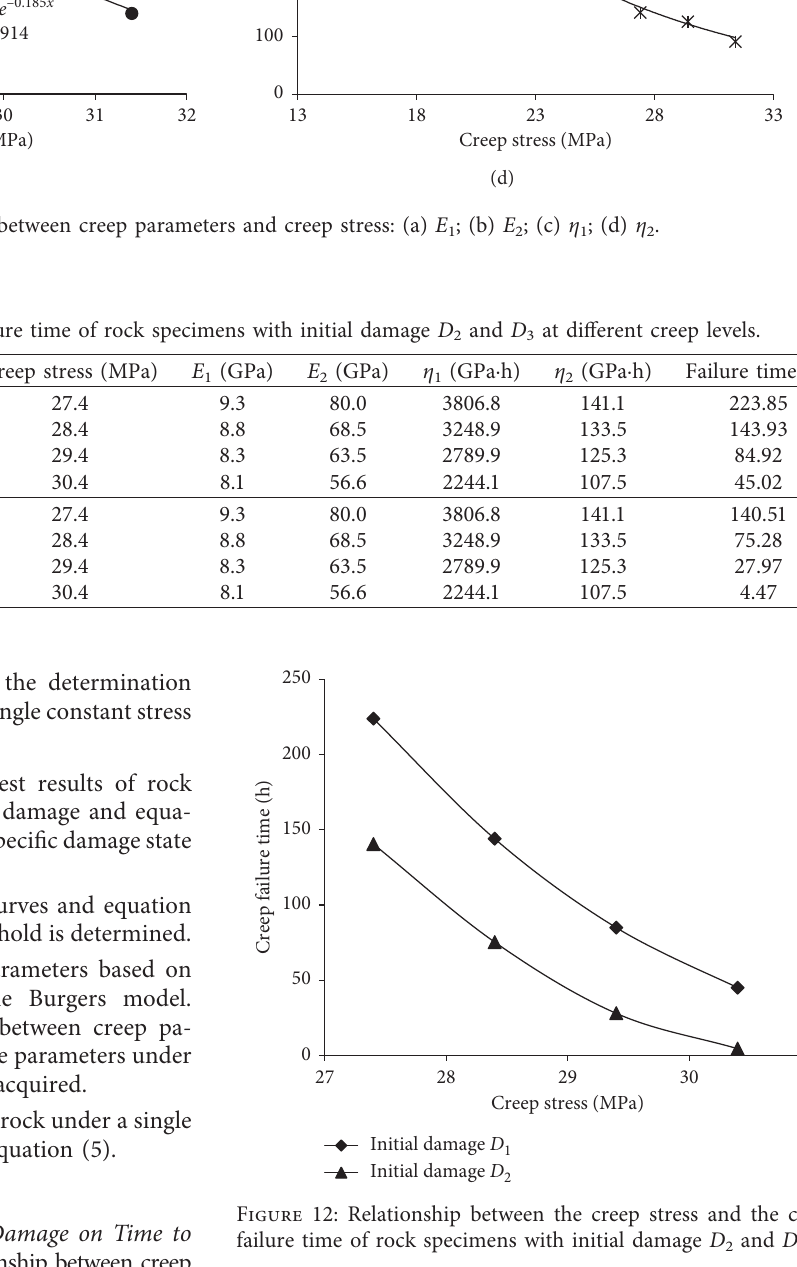
1 ; (b) E 2 ; (c) η 1 ; (d) η 2 .